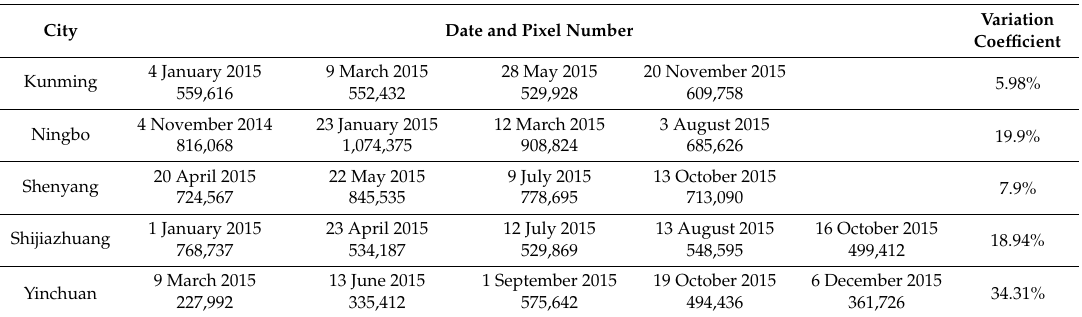
Table 2. Number of pixels classified as impervious surfaces and the coefficient of variation across time points.